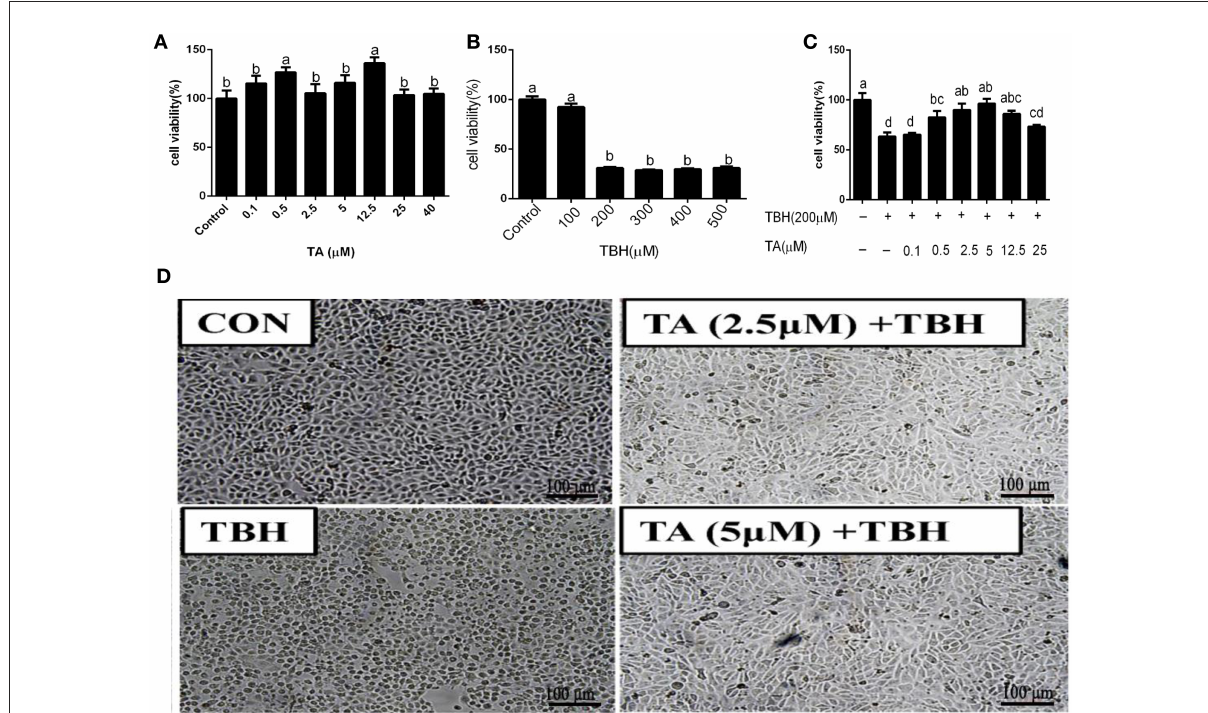
FIGURE3 Effects of tannic acid (TA) and tert-butyl hydroperoxide (TBH) on the cell viability of IPEC-J2 cells. Cells were treated with different doses of TA for 12h (A) , treated with different doses of TBH for 3h (B) , or pre-treated with different doses of TA for 12h and treated with or without 200 µ M TBH for 3h (C) , and then assayed for cell viability. The representative picture of the morphology of IPEC-J2 cells treated with TA and TBH at 100 × magnification (D) . Data are presented as mean ± SEM, n = 6 for each group. TA, tannic acid; TBH, tert-butyl hydroperoxide. a,b values in the same row not sharing a common superscript differ